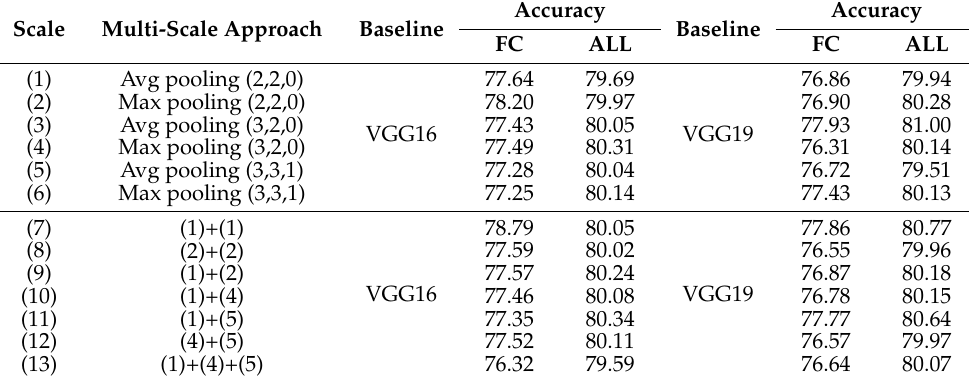
Table 2. Classification accuracy on MIT indoor67 for